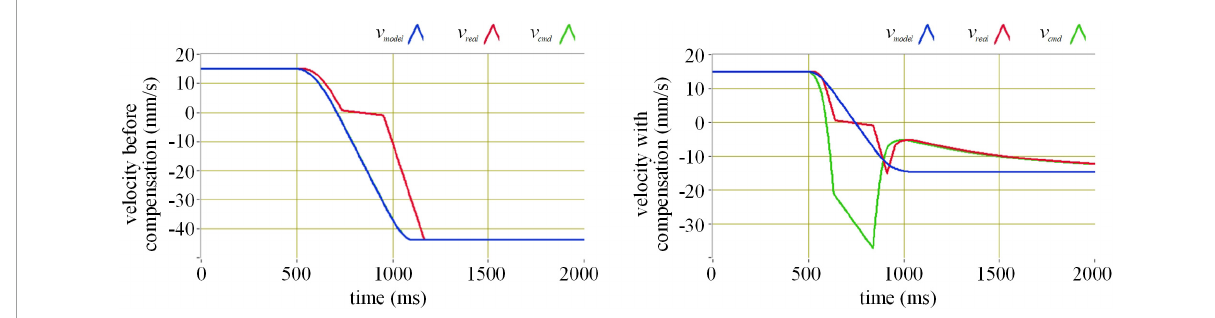
FIGURE8 The effect of actuation compensation at velocity 15 mm/s in simulation. Where the blue line represents the command velocity, the red line the execution velocity, and the green line the command velocity after the compensation.